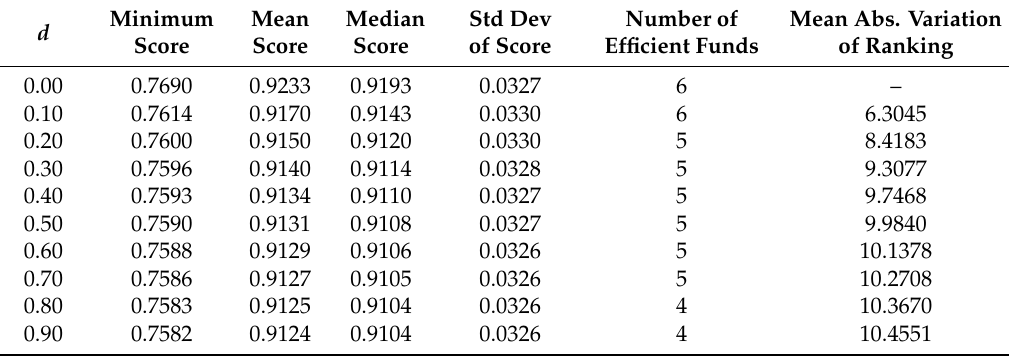
Table 13. Main results for AR restrictions in the case of asymmetric bounds and T = 1. Summary statistics on the performance scores (minimum, mean and median values, standard deviation), number of efficient funds and mean absolute variation (divided by 2) of the ranking